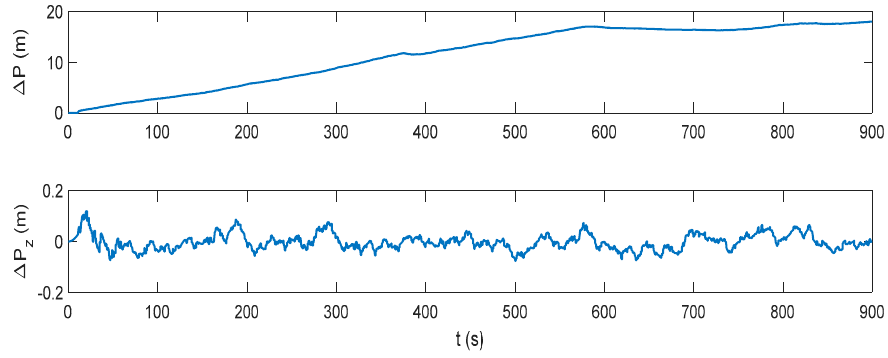
Figure 11. Position error of the IMM-aided ZUPT solution.